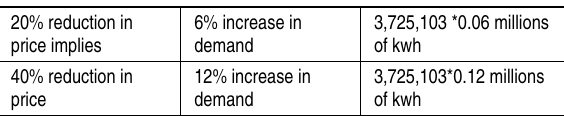
Table 1. Electricity demand changes from price reductions